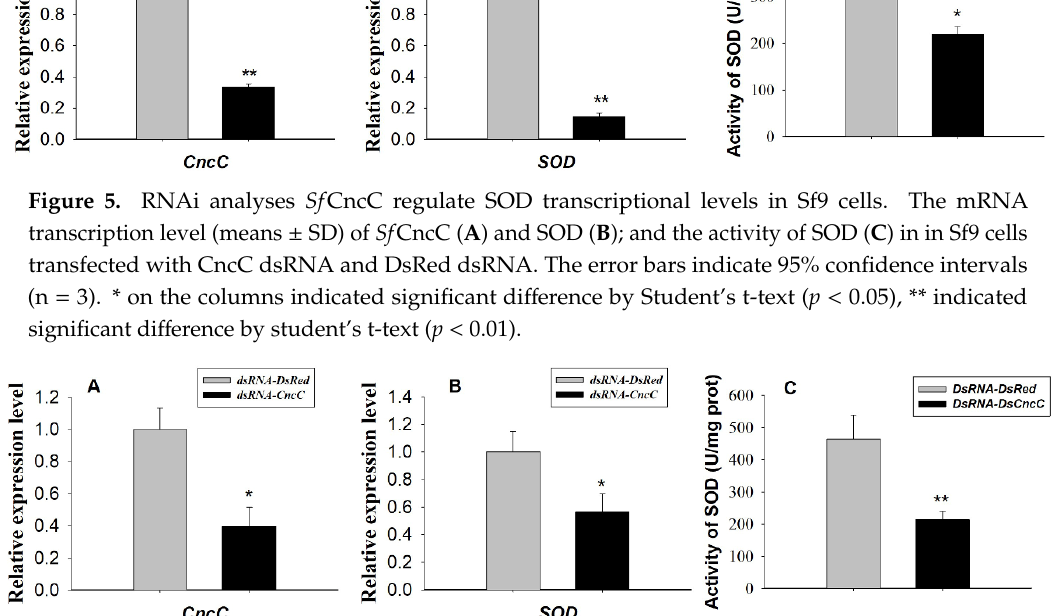
Figure 6. RNAi analyses of Sf CncC regulate SOD transcriptional levels and SOD activity in larvae. The mRNA transcription level (means ± SD) of Sf CncC ( A ) and SOD ( B ), and activity of SOD ( C ) in larvae injected with CncC dsRNA and DsRed dsRNA (1 µ g / per larva). The error bars indicate 95% confidence intervals (n = 3). * on the columns indicated significant difference by student's t-text ( p < 0.05), ** indicated significant difference by student's t-text ( p < 0.01).